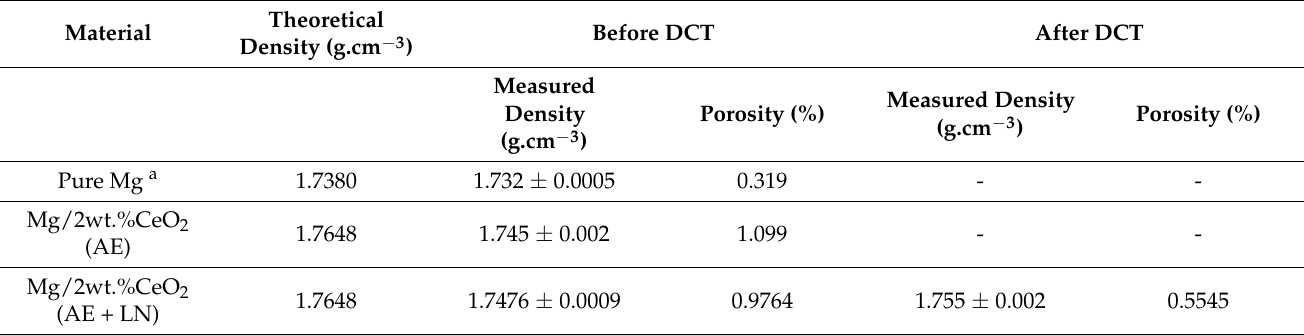
Table 1. Results of density and porosity of Mg/2wt.%CeO 2 composite before and after DCT.